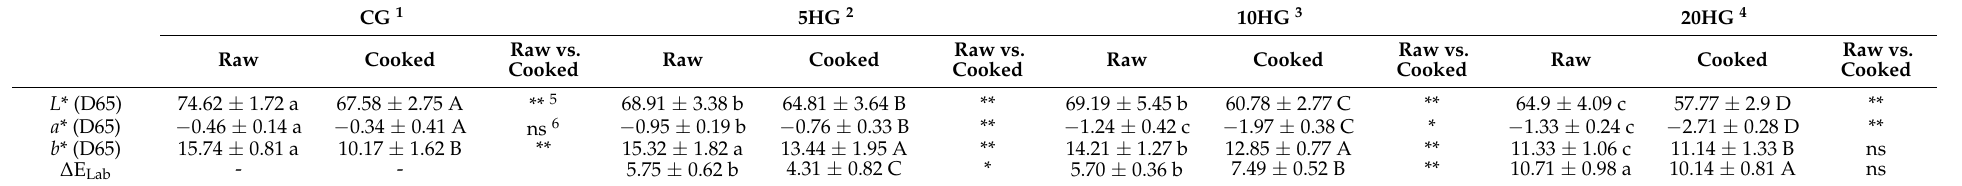
Table 5. Color profile of control and hemp seed flour-enriched gnocchi samples.